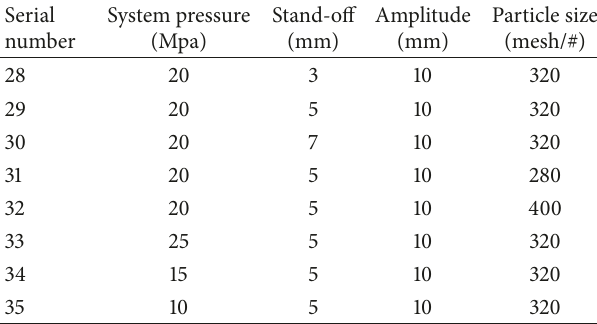
Table 4: The experiment